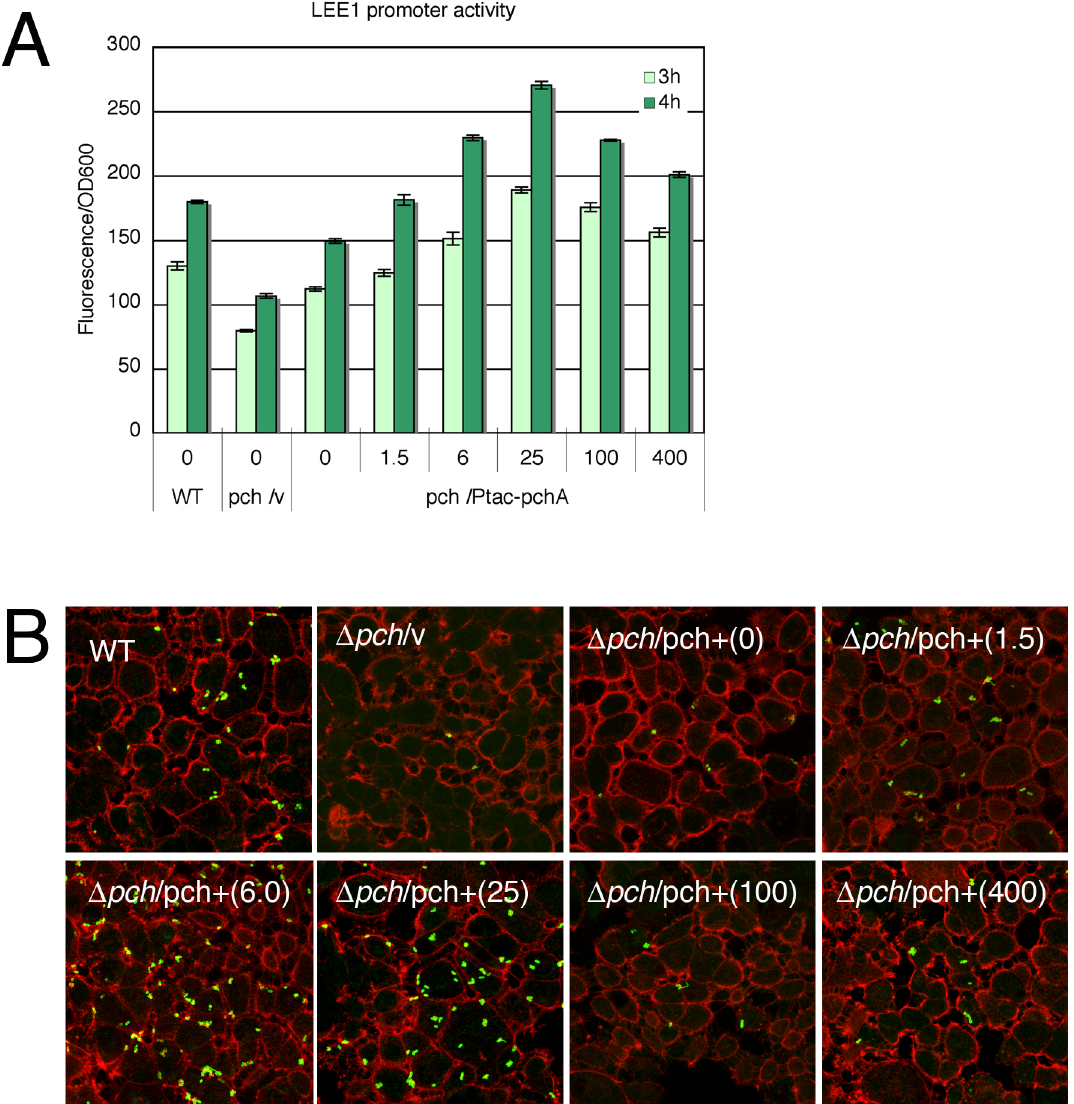
Fig 1. Activation of LEE gene expression and adherence capacity by increasing pch expression. A. Dose effect of Pch on LEE1 promoter activity. The pch mutant of EHEC harboring the P tac-pchA operon fusion plasmid (pTB101- pchA ) and P LEE1 -gfp operon fusion plasmid (pSU-gfp-P LEE1 ) was grown in DMEM containing various amounts of IPTG. LEE1 promoter activity was measured as expression levels of GFP, which was controlled by the LEE1 promoter. The activities were assayed at 3 or 4 h from the start of bacteria growth after a 100-fold dilution of overnight culture. B. Dose effect of Pch on adherence capacity. After growth in DMEM containing various amounts of IPTG (shown in parenthesis), bacteria were incubated with Caco-2 cells, and adherent bacteria were visualized by fluorescent staining with an anti-O157 LPS antibody and an Alexa488 secondary antibody. F-actin was visualized by staining with